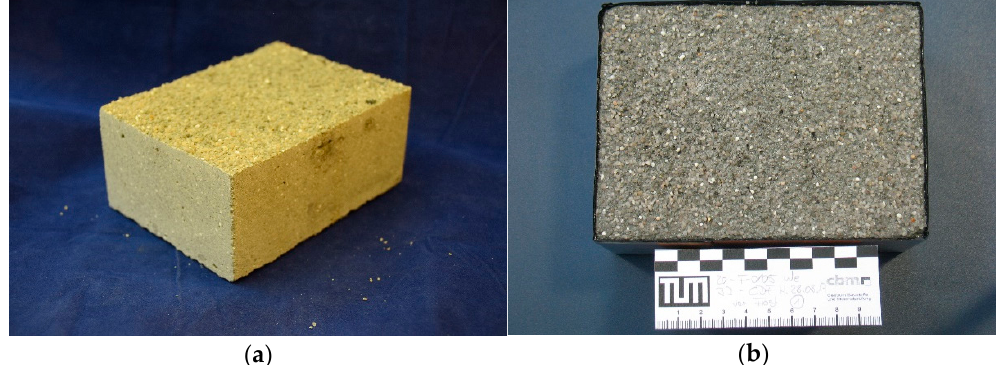
Figure 8. 3D printed (90°) specimen with (CDF) and without (CIF) deicing salt ( a ) with already sawn edges before sealing with Teflon tape with untreated test surface and ( b ) sealed with Teflon tape.